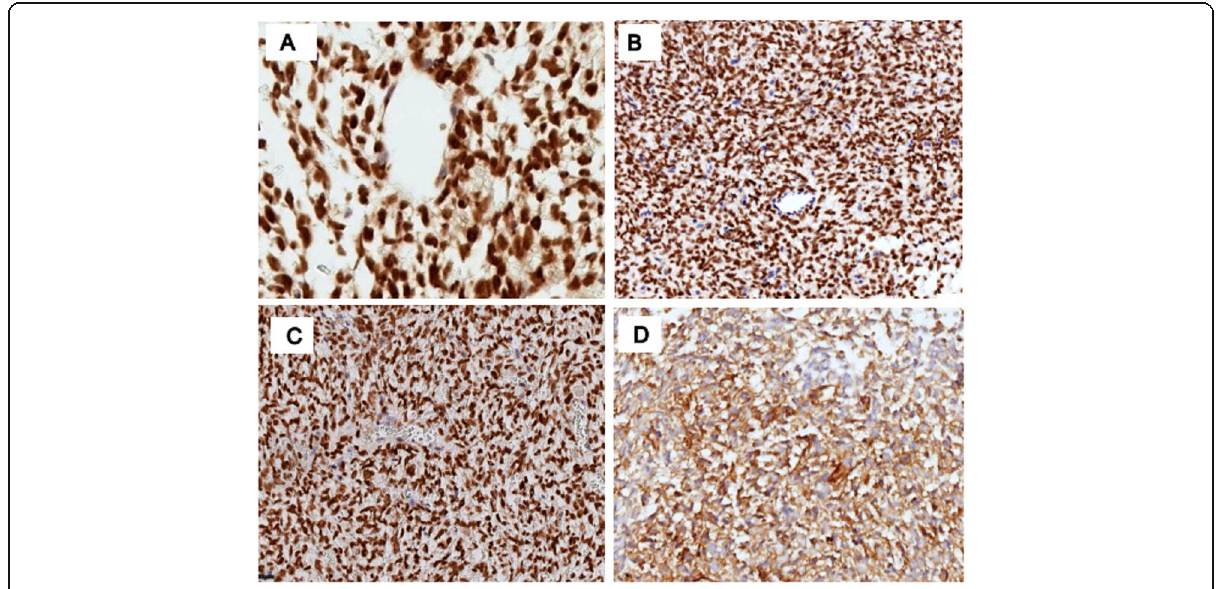
Fig. 3 Immunohistochemistry features of BCS. A The tumor cells were CCNB3 positive. B The tumor cells were BCOR positive. C The tumor cells were TLE1 positive. D The tumor cells were CD99 focally positive in the cytoplasm. Immunoperoxidase, original total magnification × 200 ( A - D